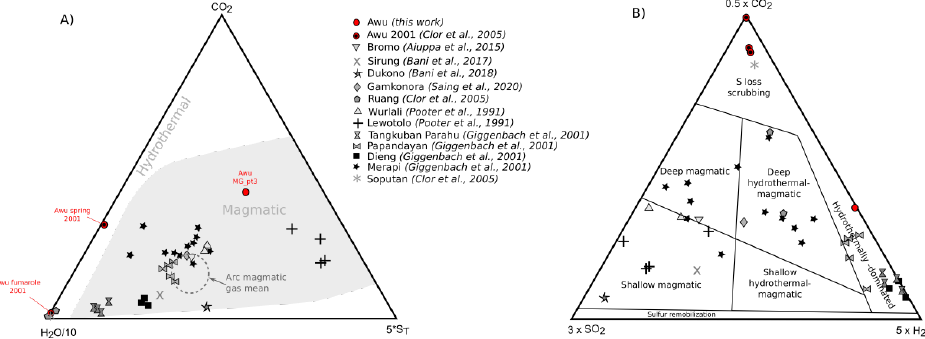
Figure 6. The CO 2 –H 2 O–ST ternary diagram highlighting the hydrothermal gas composition at Awu in 2001 ( A ) with strong S-loss by scrubbing processes ( B ). In contrast, in 2015 Awu’s gas had a magmatic signature ( A ) influenced by a hydrothermal manifestation ( B ). The gas compositions of other Indonesian active volcanoes available in the literature are plotted for comparison.